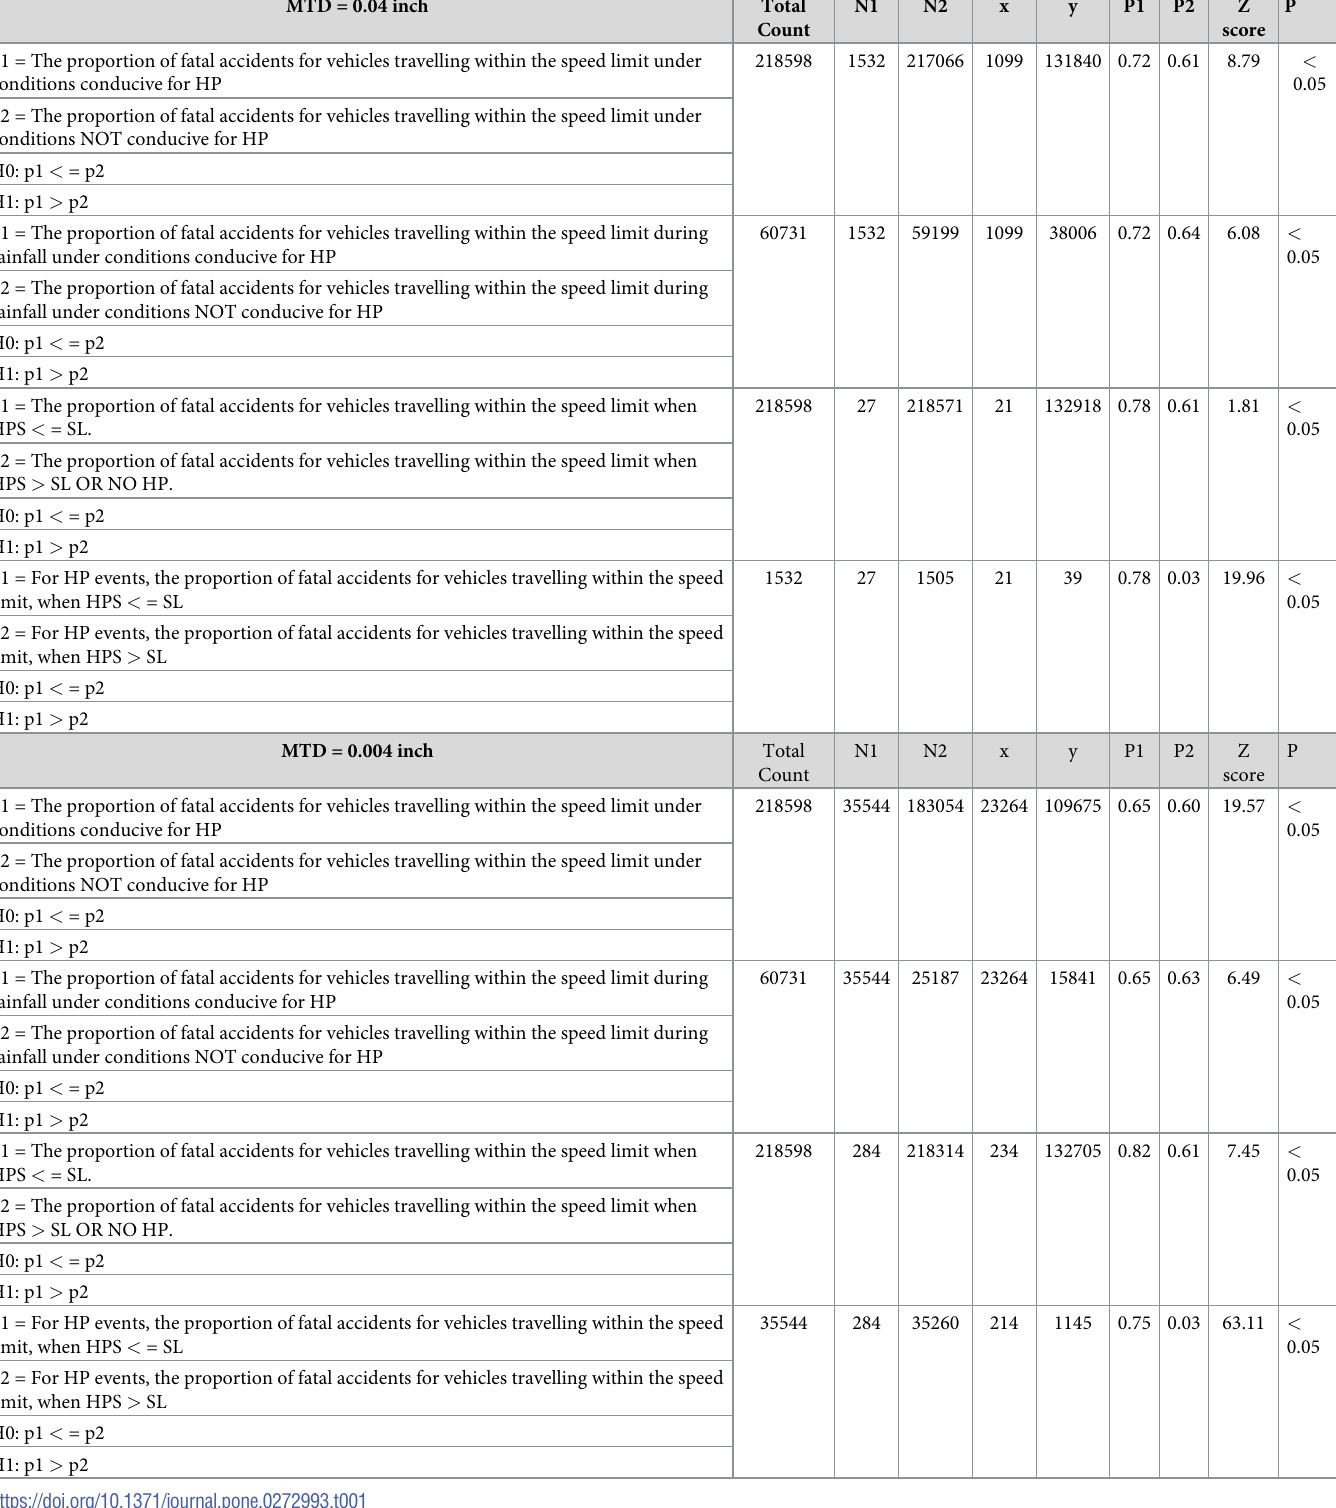
Table 1. Details of the four hypothesis tests carried out to assess if the occurrence of hydroplaning and high-risk events increase the risk of fatal accidents. MTD = 0.04